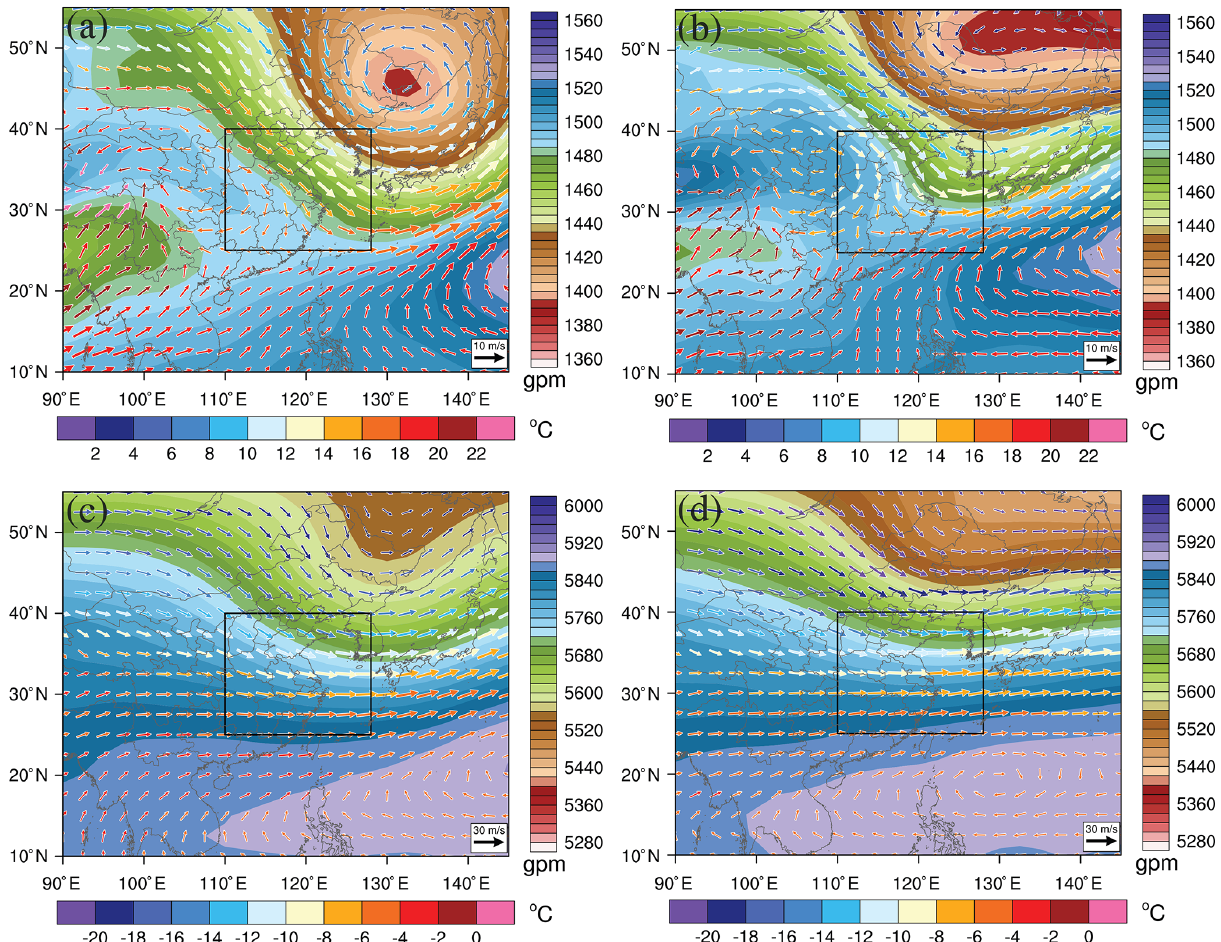
Figure 5. The geopotential height (shaded) and 850hPa wind with temperature (color vector) under (a) SWP2_Pos and (b) SWP2_Neg. The geopotential height (shaded) and 500hPa wind with temperature (color vector) under (c) SWP2_Pos and (d) SWP2_Neg. The boxed area in panels (a) – (d) encloses the